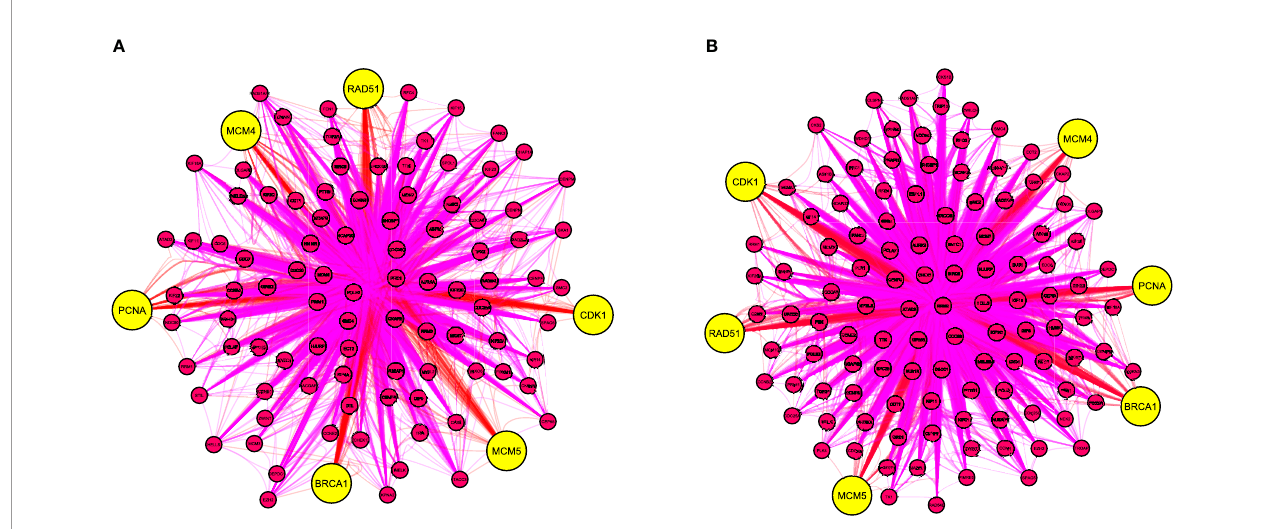
FIGURE 3 | The top 10 overlapping hub genes of clustering modules in the protein-protein interaction network of differentially expressed genes from (A) CIN and (B) CC patients. Yellow nodes indicate hub genes. BRCA1, BRCA1 DNA repair associated; CIN, cervical intraepithelial neoplasia; CC, cervical cancer; CDK1, cyclin dependent kinase 1; MCM4, minichromosome maintenance complex component 4; MCM5, minichromosome maintenance complex component 5; PCNA, proliferating cell nuclear antigen; RAD51, RAD51